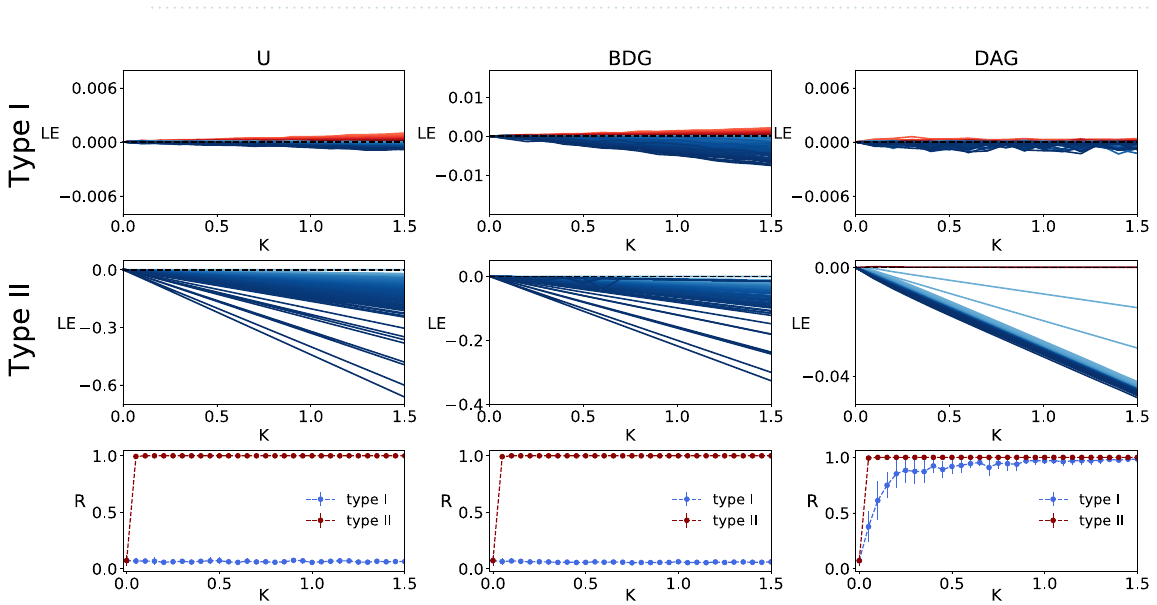
Figure 3. Structural properties of two different directed networks. Adjacency matrices (top) and the location of Laplacian eigenvalues in the complex plane (bottom), for small-world and scale-free BDGs and DAGs with 200 nodes and average degree of 6. Schematic illustrations of BDGs and DAGs constructed from the same undirected backbone are shown at the right. The source node is highlighted with red colour.